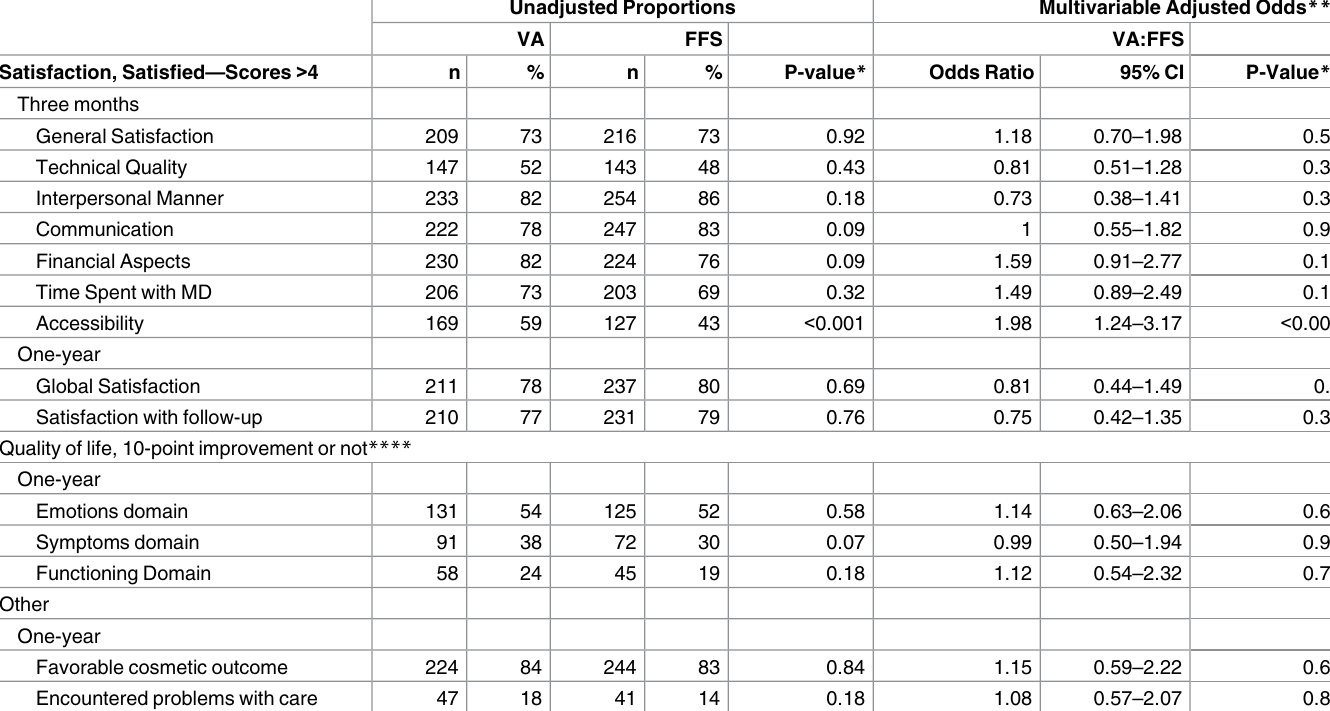
Table 3. Patient-Reported Outcome